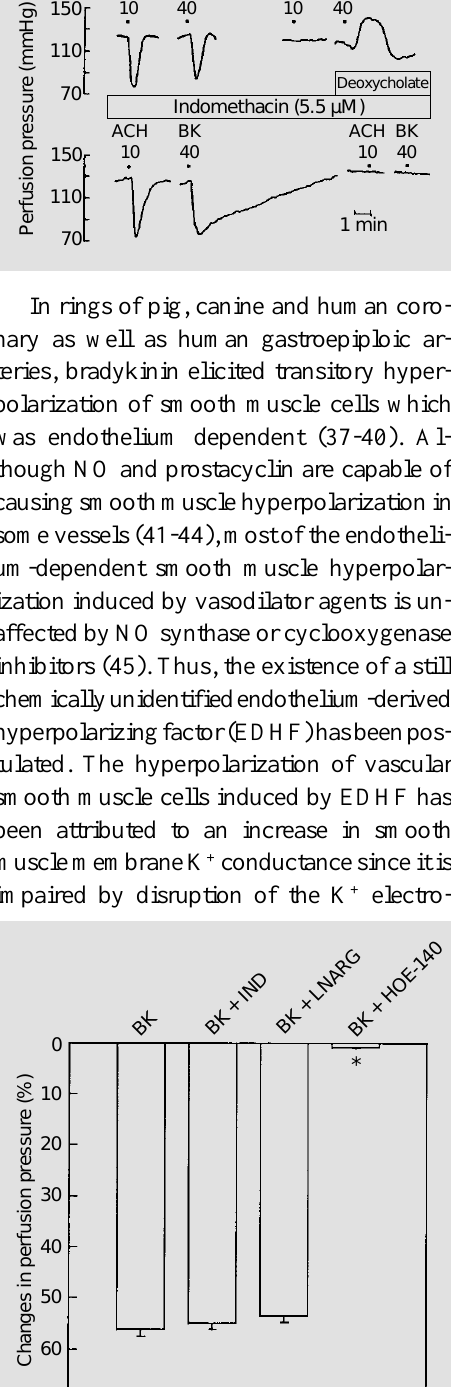
Figure 2 - Typical recordings show examples of the effect of endothelium removal with so- dium deoxycholate on the re- sponse to acetylcholine (ACH; 10 ng) and bradykinin (BK; 40 ng) in preconstricted rat isolated mesenteric arterial bed per- fused with Krebs’ solution (top panel) or Krebs’ solution con- taining the cyclooxygenase in- hibitor indomethacin (bottom panel).